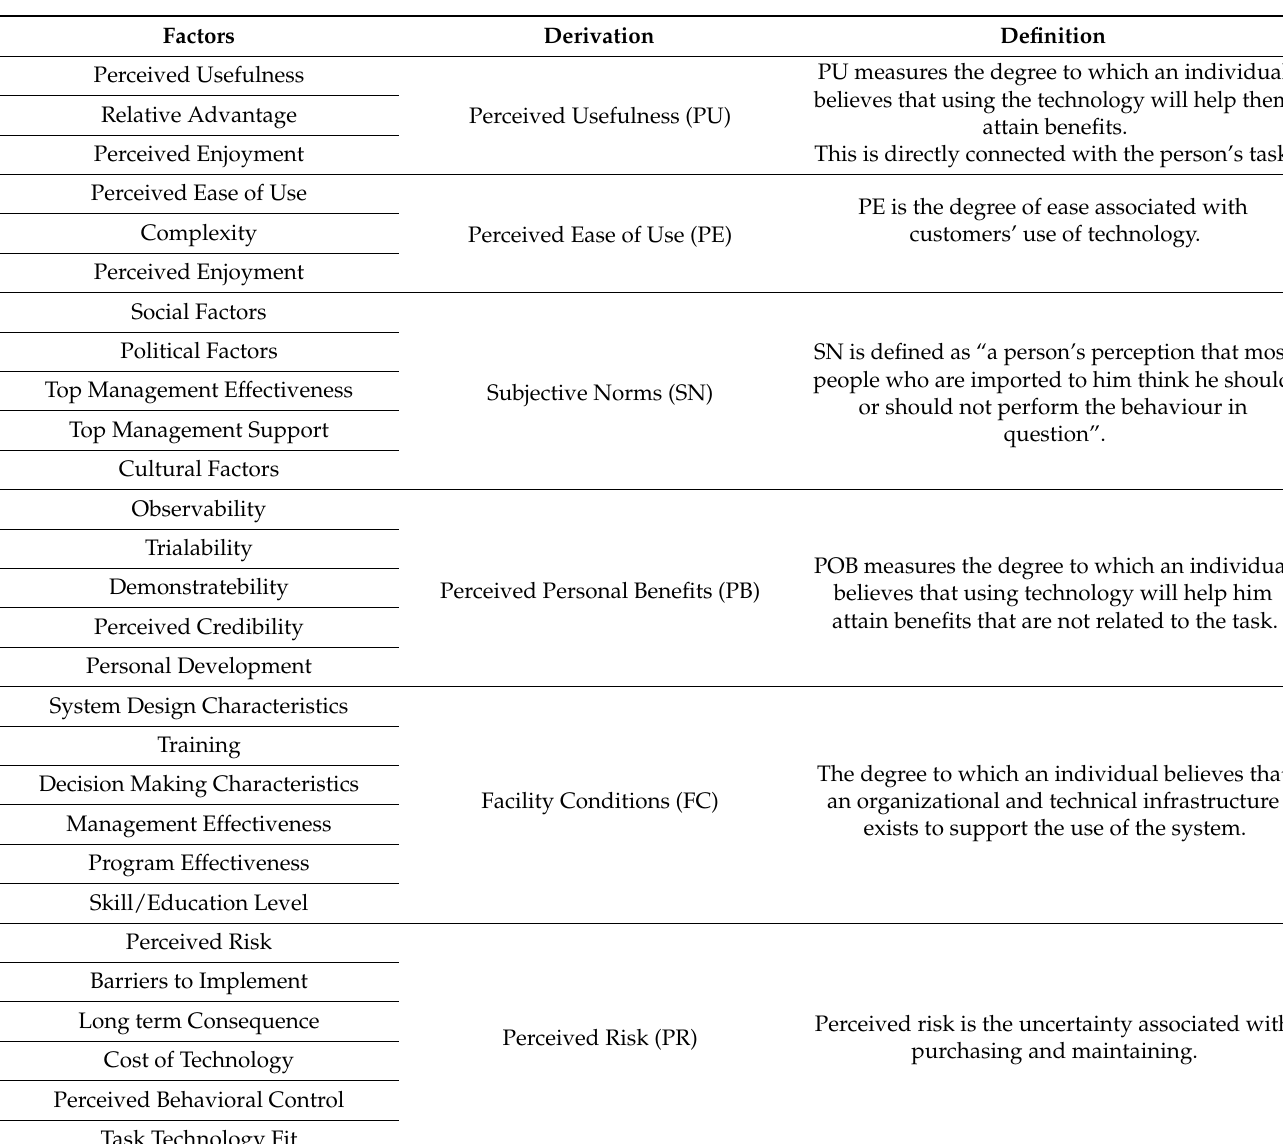
Table 2. Deriving factors for the conceptual